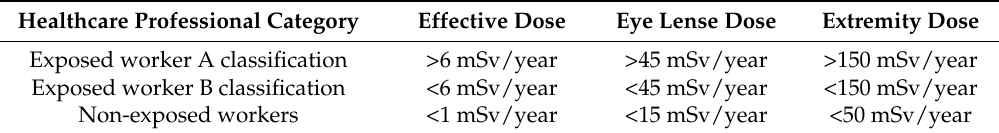
Table 1. Dose level ranged by exposition category.